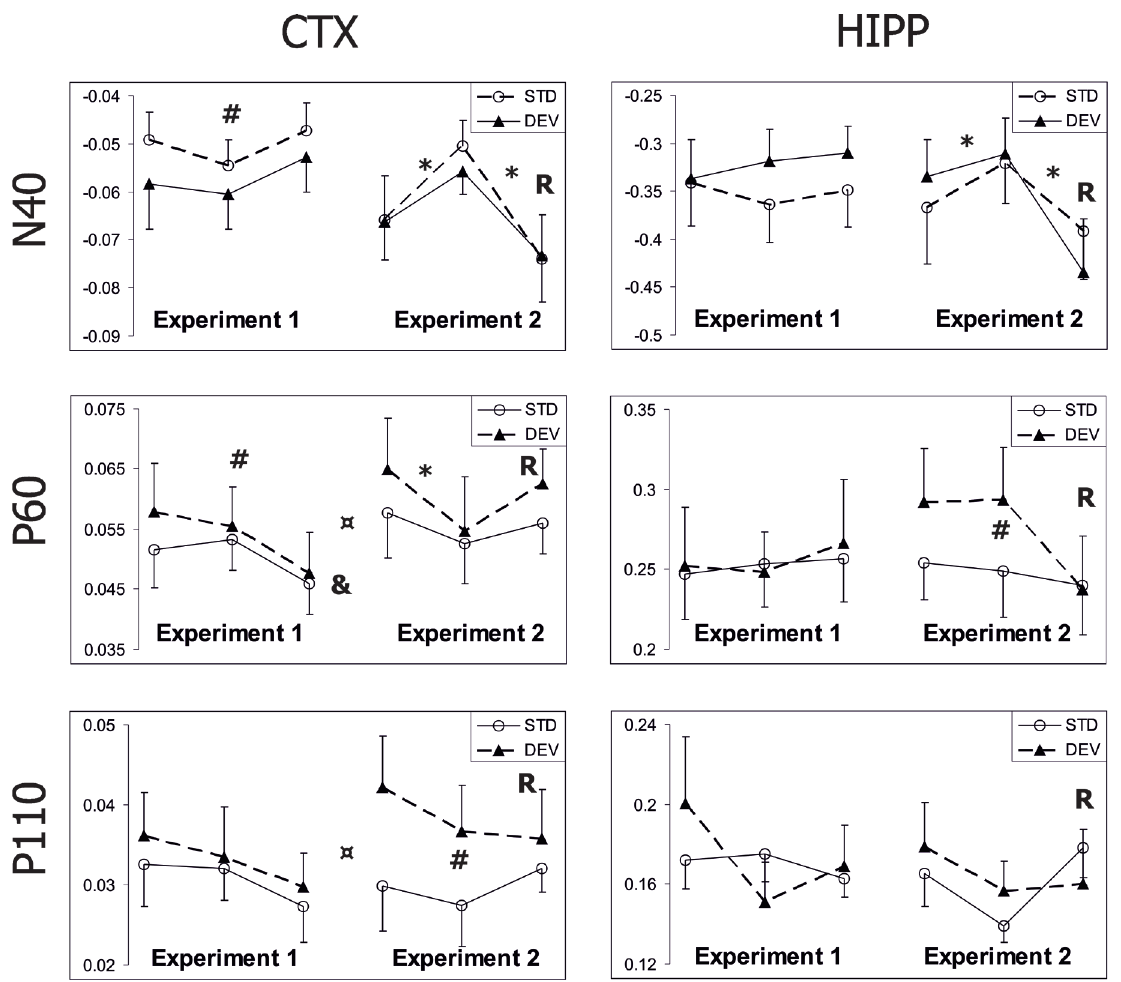
Figure 3. Effect of repetition on the AEP in response to the standard and the deviant tones. Mean amplitudes of AEP components (N40, P60, P110) ± SEMs are given. In each chart the x-axis represent different runs of the test. Note the break between Run 3 of Experiment 1 and Run 1 of Experiment 2 to indicate the intervening days. R under Run 3 of Experiment 2 indicates reversal of the mismatch contingency. * significant difference between consecutive Runs; ¤ significant difference between Run 3 of Experiment 1 and Run 1 of Experiment 2; # significant difference between standard and deviant responses; & significant repetition effect on component